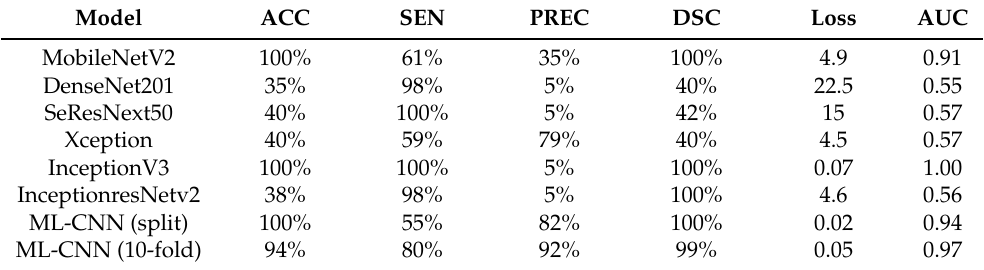
Figure 10. The output images with the predicted ODs and the actual GTs ( a ) an image that has TSLN and predicted to have DR, TSLN, and MH ODs, and ( b ) an image that has DR and LS diseases and predicted to have TSLN, DR, and MH ODs. Table 8. The comparison of the proposed ML-CNN model with some state-of-the-art DL techniques.